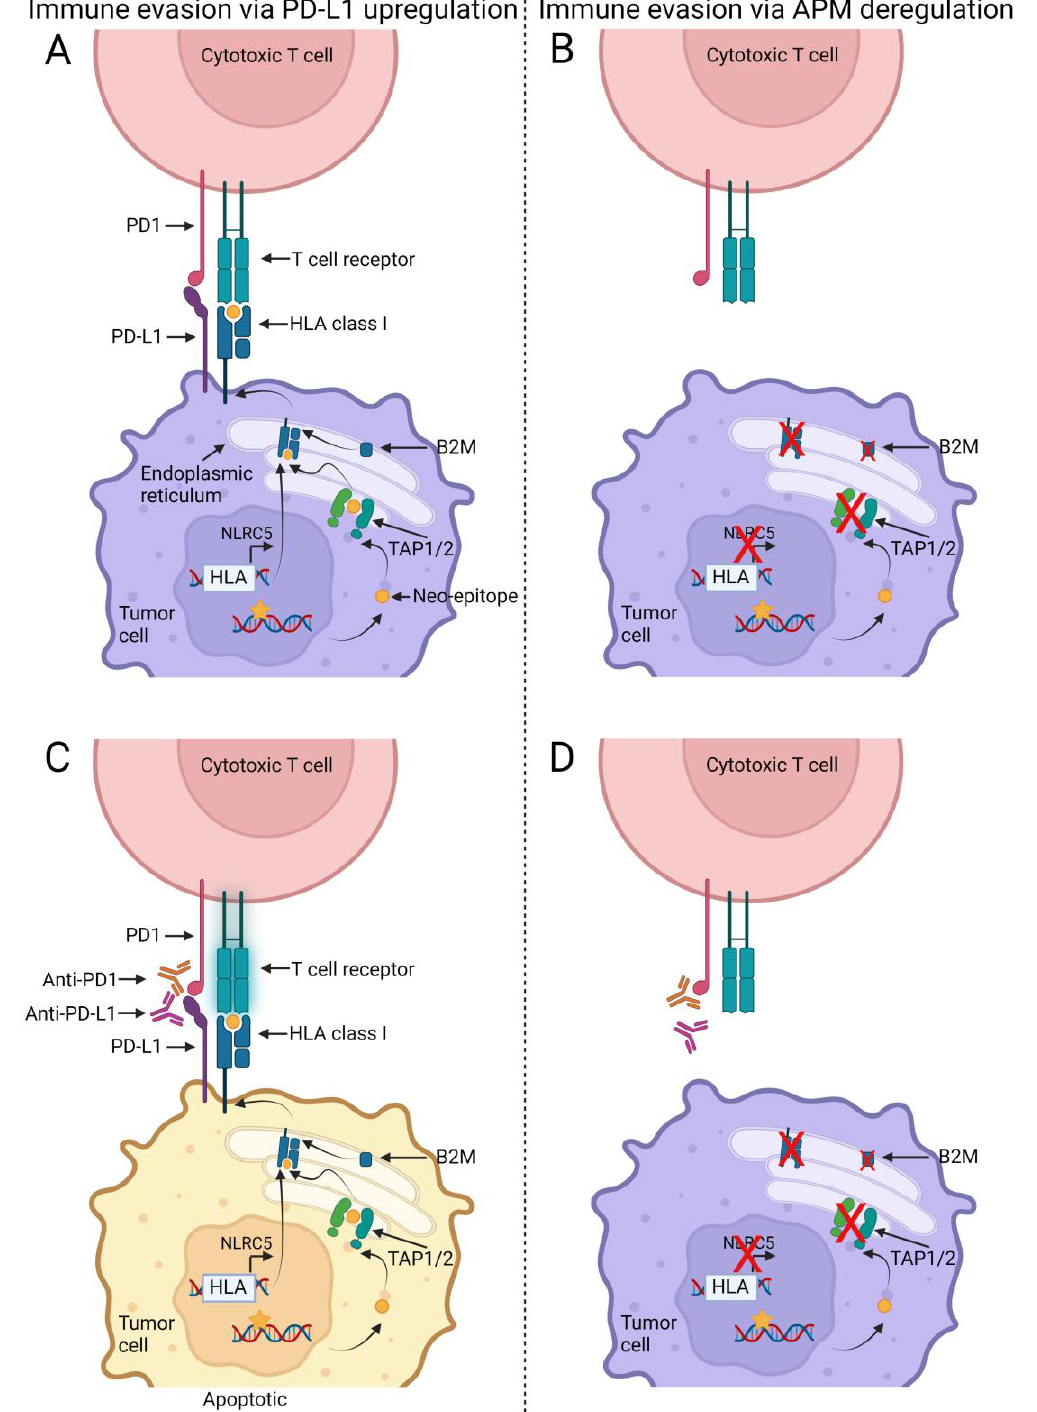
Figure 1. Model for non-responders and responders in relation to immune checkpoint inhibitors (ICI) and antigen presentation machinery (APM). DNA mutations (yellow star) generated by replicative errors during tumor cell division may result in altered protein structures. These proteins are degraded into smaller fragments (neo-epitopes) (yellow circle) that are imported into the endoplasmic reticulum and loaded onto the human leukocyte antigen (HLA) class I receptors by the transporter associated with antigen processing (TAP) 1 and TAP2. Prior to the loading the HLA class I molecule has been assembled with its essential subunit, beta-2 microglobulin (B2M). The assembled HLA class I receptor is transported to the cell surface where the T cell receptor on the cytotoxic T cells recognize the neo- epitope as foreign and in turn induce apoptosis in the tumor cell. The tumor cell can up-regulate the programmed death 1 ligand 1 (PD-L1) receptor and thereby inhibit the activity of the T cell ( A ). This